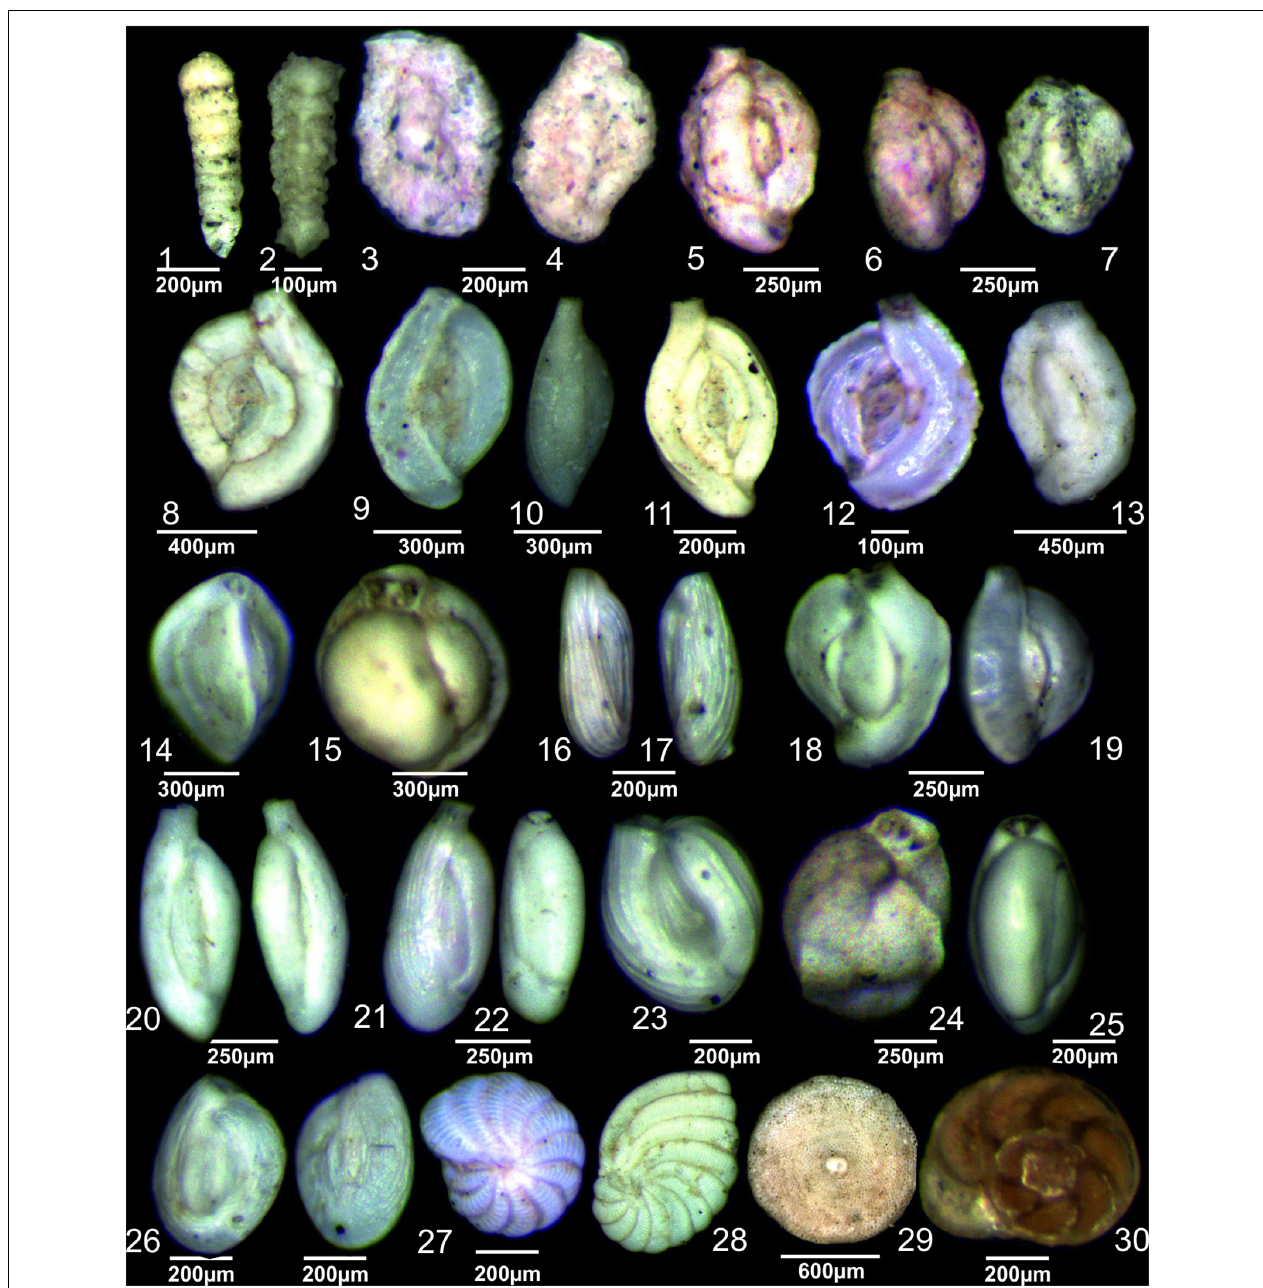
FIGURE 5 | 1 Clavulina multicamerata, side view; 2 Clavulina angularis, side view, 3–4 Agglutinella compressa, side view; 5–6 Siphonaperta pittensis, side view; 7 Siphonaperta cf. S. agglutinans, side view; 8 S. rugosa, side view, 9 Spiroloculina sp. side view; 10 Spiroloculina sulcata, side view; 11 Spiroloculina communis , side view; 12 Spiroloculina costigera, side view; 13 Lachlanella subpolygona, side view; 14 Triloculina tricarinata , side views; 15 Triloculina trigonula , apertural views; 16–17 Q. limbata , side views; 18–19 Quinqueloculina lamarckiana, side views; 20 Cycloforina sulcata , side view; 21–22 Cycloforina carinatastriata , side views; 23 Triloculina fichteliana , side views; 24 Triloculina serrulata , side view; 25 Triloculina cf. T. schreiberiana , side view; 26 Varidentella neostriata, side views; 27 Coscinospira hemprichii , side views; 28 Peneroplis planatus , side view ; 29 Sorites orbiculus , side view; 30 Ammonia convexa , spiral views.